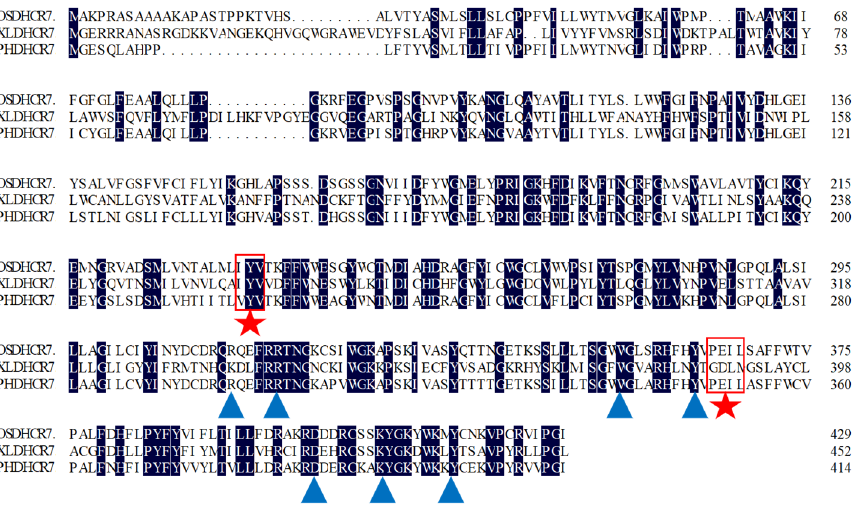
Figure 2. Full ‐ length amino acid sequence alignment of DHCR7s from Physalis angulata , Xenopus laevis , and Oryza sativa . Blue triangles represent the putative NADPH binding sites; red pentagrams represent the putative binding sites for the hydroxyl groups of sterol acceptors.